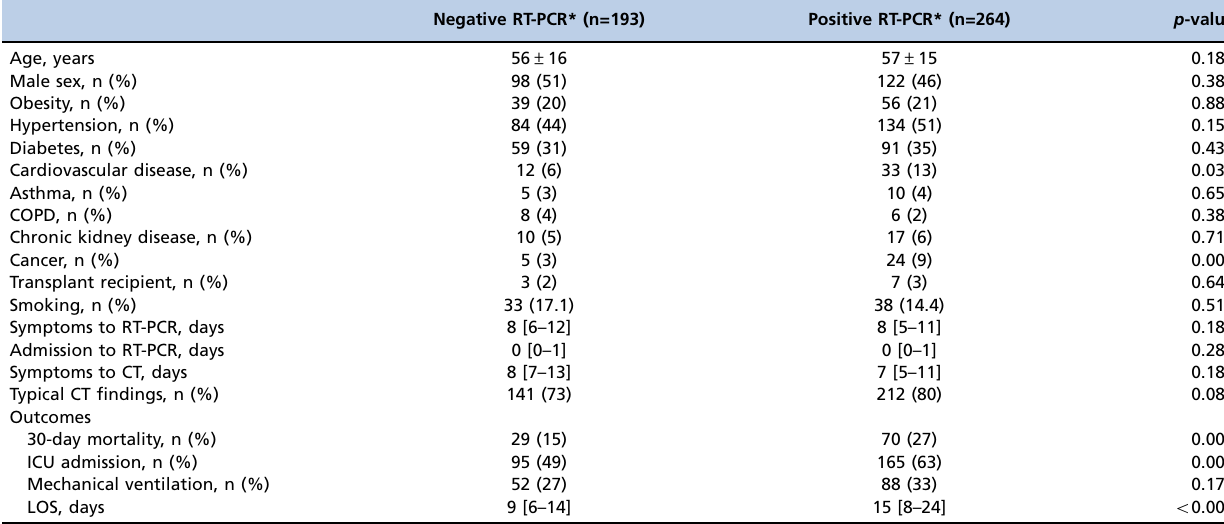
Table 2 - Baseline characteristics and outcomes of admitted patients, stratified by RT-PCR